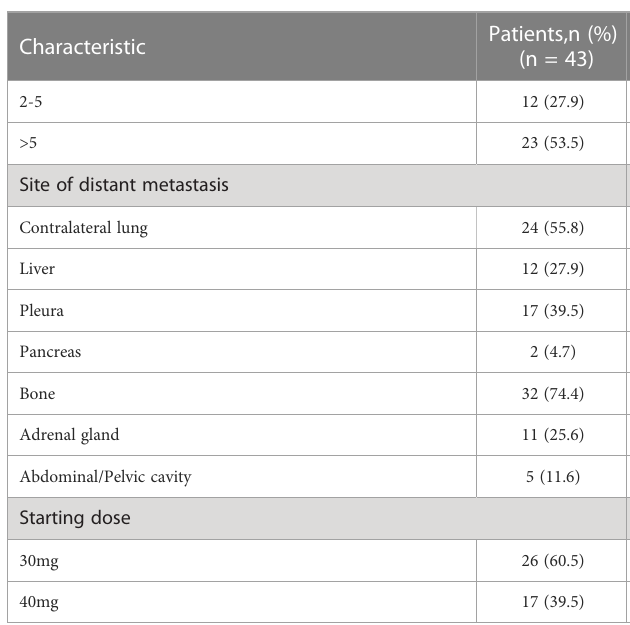
TABLE 1 Baseline demographics and clinical characteristics of patients.